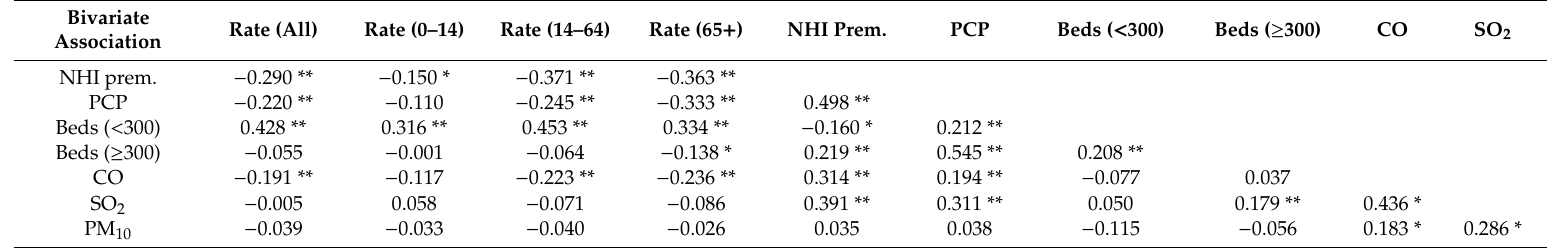
Table 3. Correlation matrix of dependent and independent variables.